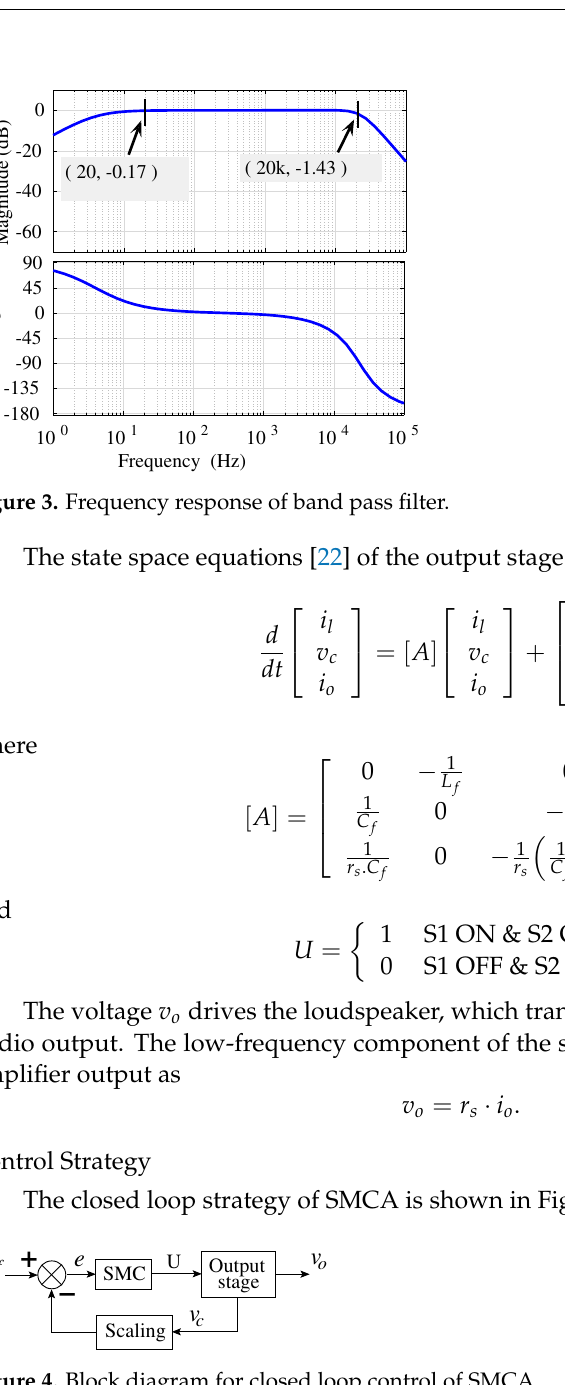
Figure 4. Block diagram for closed loop control of SMCA. The reference v ref and scaled output voltage β · v c are applied to the summer